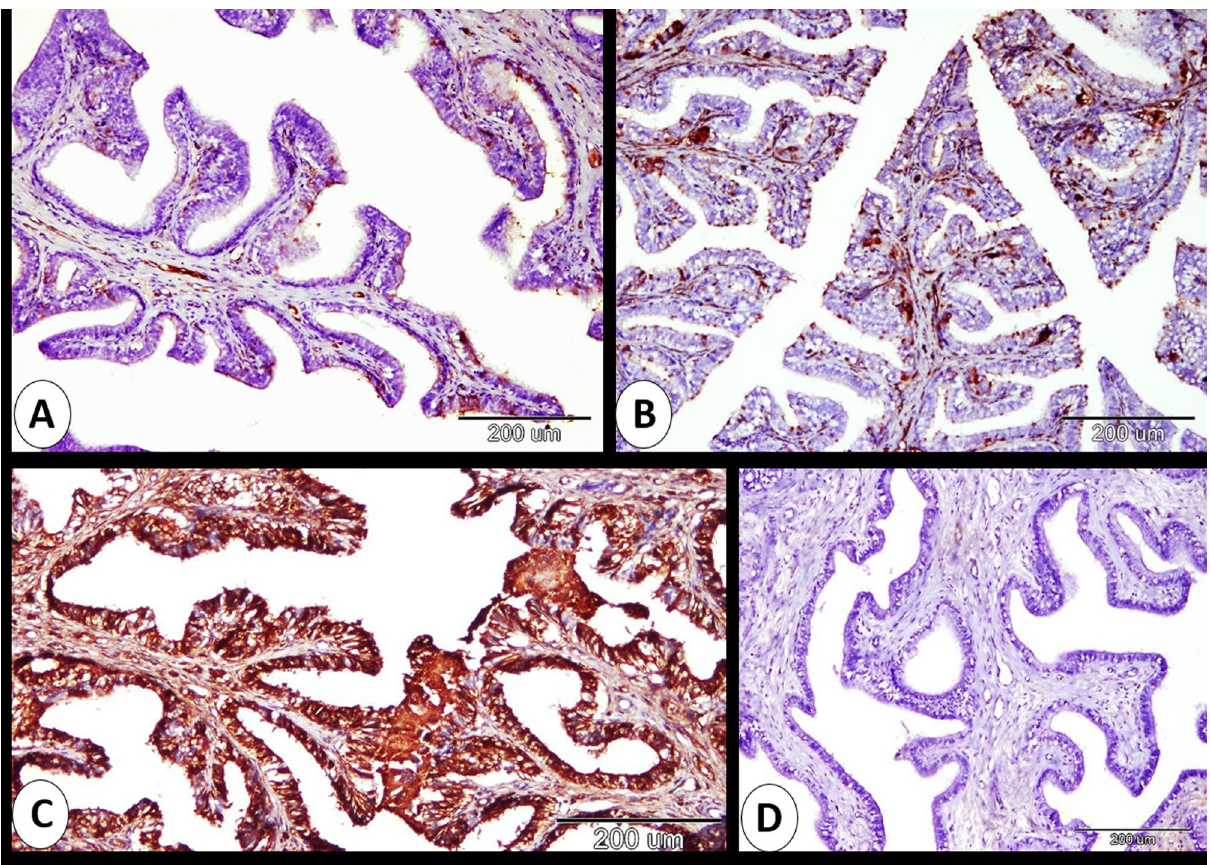
Figure 6. Immunohistochemical localization of ERA in rabbit cervix at 0, 7, 14 and 21 days of pregnancy. ( A ) Mild immunostaining of the rabbit cervix at 0 day of pregnancy. ( B ) Moderate immunostaining of the rabbit cervix at 7 days of pregnancy. ( C ) strong immunostaining of the rabbit cervix at 14 days of pregnancy (l). ( D ) mild immunostaining of the rabbit cervix at 21 days of